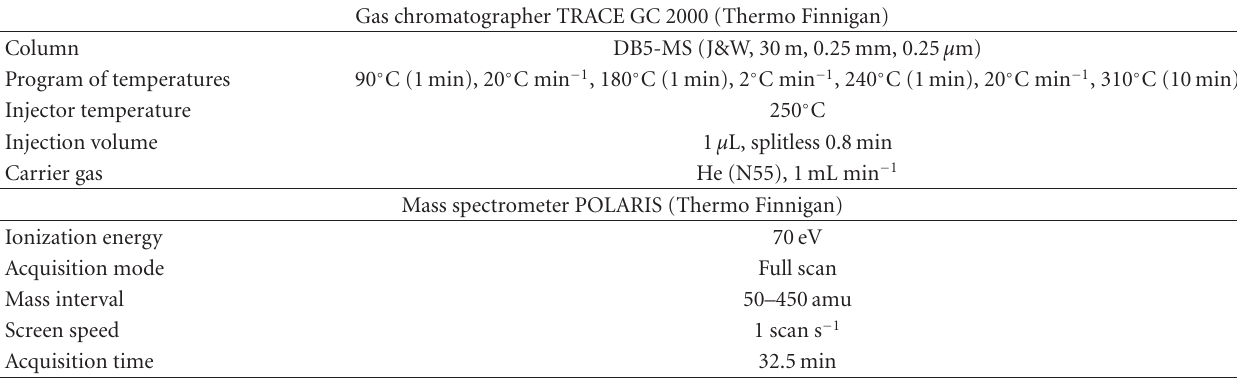
Table 2: Conditions of pesticide